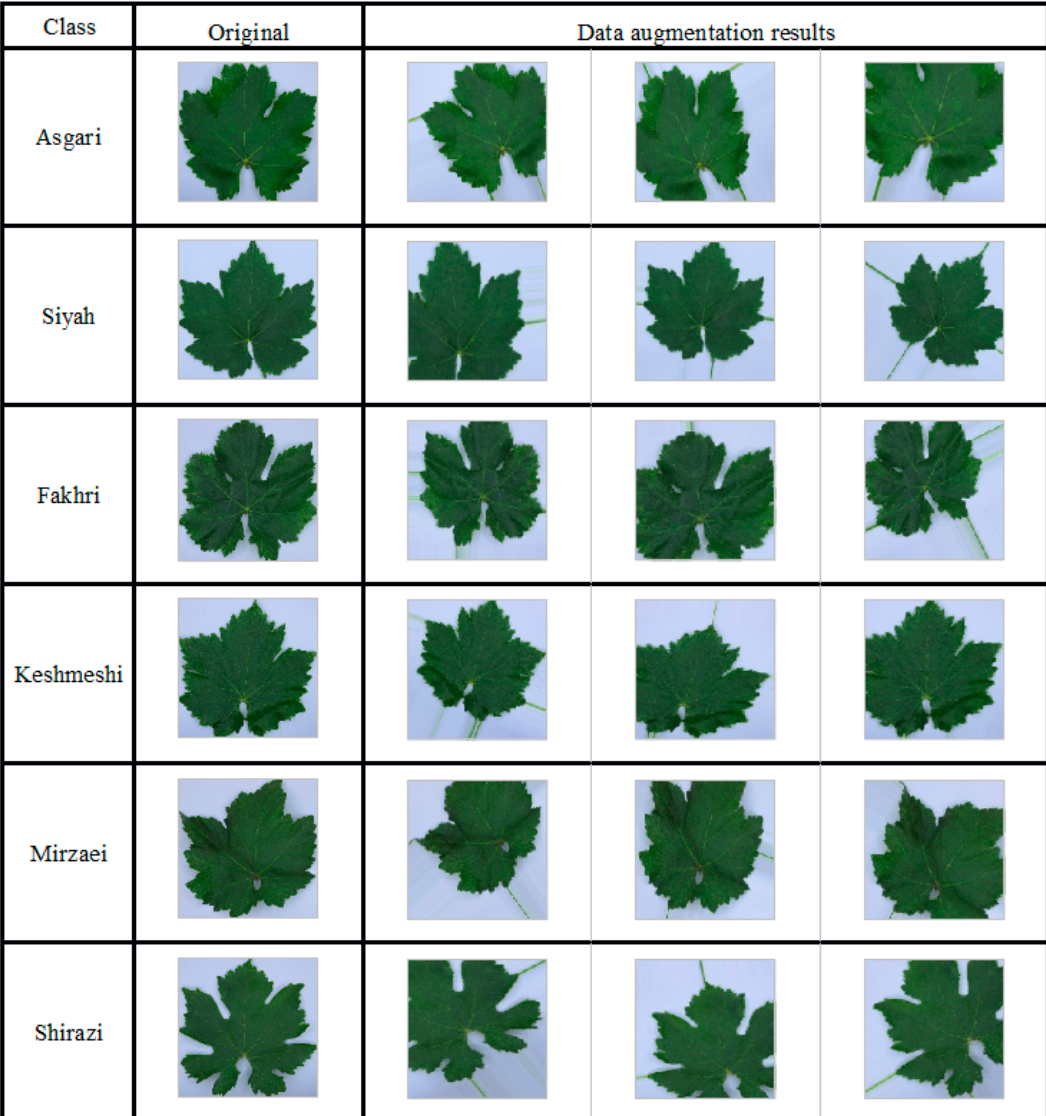
Figure 3. Representative augmented images of the six grapevine cultivars under study.